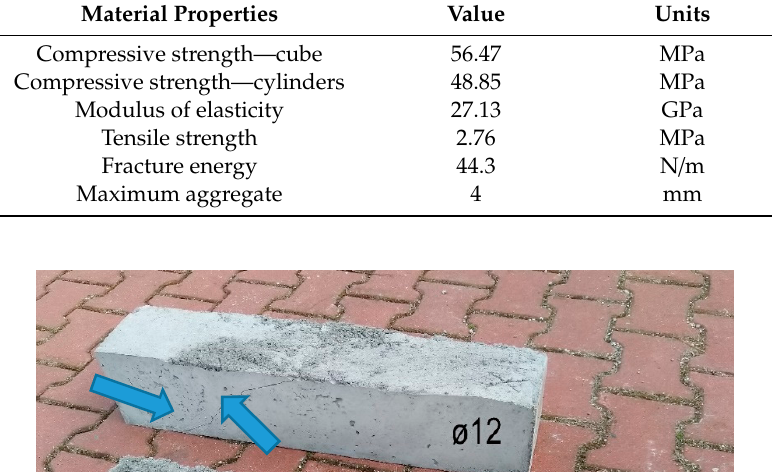
Table 8. Results of mechanical properties for concrete.